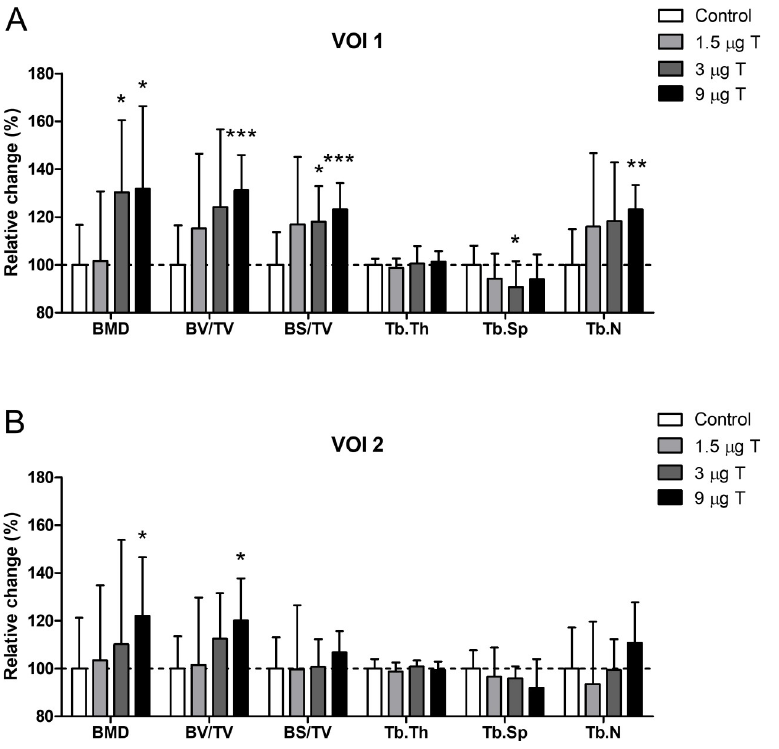
Fig 5. MicroCT analysis of rabbit femoral condyle implantation model after 8 weeks. Trabecular bone adjacent to the screw at a distance of 0.3 to 0.8 mm from the screw surface (VOI1), showed dose dependent increases in the following bone parameters, bone mineral density (BMD), bone volume fraction (BV/TV), bone surface fraction (BS/ TV) and trabecular number (Tb.N) for testosterone (T) and alendronate (2 μ g) coated screws, while trabecular thickness (Tb.Th) and trabecular spacing (Tb.Sp) did not (A, n = 9–10). Trabecular bone adjacent to the screw at a distance of 0.8 to 1.3 mm from the screw surface (VOI2), only showed increased BMD and BV/TV for screws coated with 9 μ g testosterone and 2 μ g alendronate (B, n = 8–9). Significant differences compared to controls are indicated by asterisks: � p � 0.05, �� p � 0.01 and ��� p �